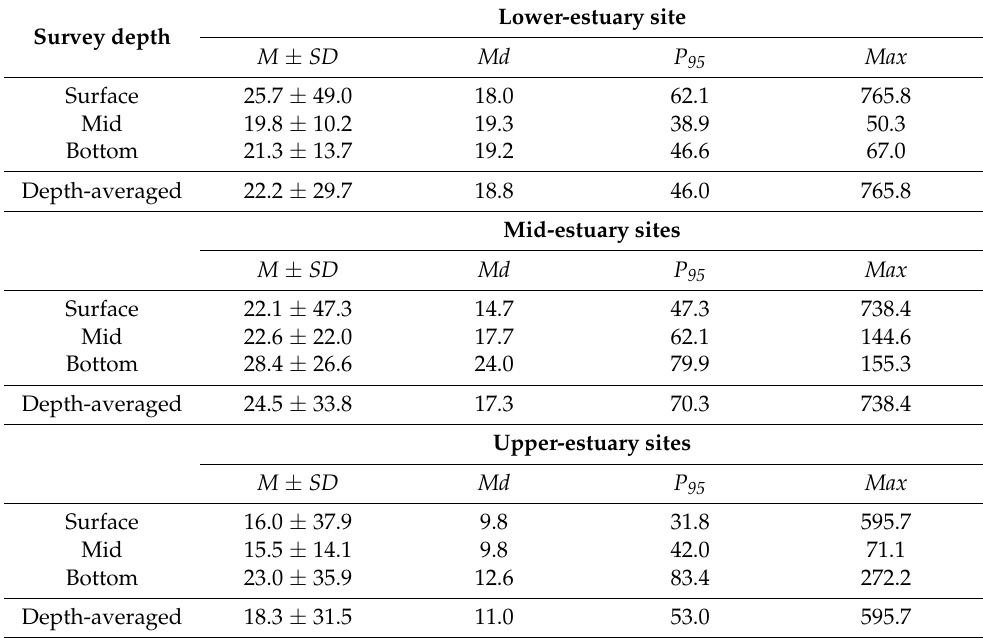
Table 2. Depth compartment and depth-averaged ( M ) ± standard deviation ( SD ), median ( Md ), 95th percentile ( P 95 ), and maximum ( Max ) volumetric concentrations [ µ L L − 1 ] within the lower- (Site 1), mid- (Sites 3, 4, and 9), and upper-estuary (Sites 5 and 7) site/s based on all sample conditions. Lower-estuary Survey depth